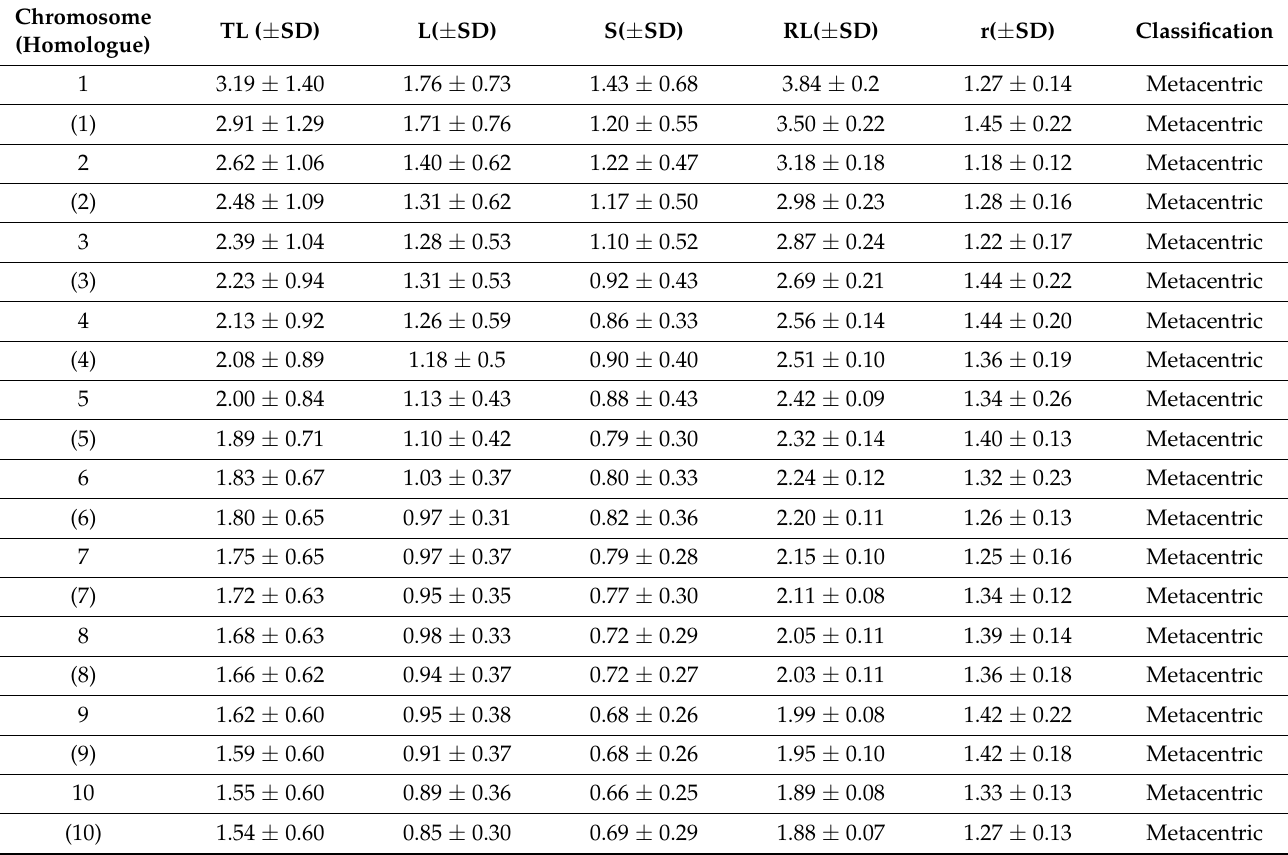
Figure 3. Mitotic chromosomes of Cyphomyrmex transversus stained with Giemsa. Species ( a ) images and ( b , c ) diploid karyotype of Cyphomyrmex transversus with 2 n = 42 chromosomes. m = metacentric, sm = submetacentric. Polymorphism in chromosome pair 15 is marked by an asterisk. Scale bar = 5 µ m. Ant image from AntWeb (www.antweb.org, accessed on 13 June 2021): Cyphomyrmex transversus (CASENT0173958, photo by: A. Nobile). Table 3. Karyomorphometric analyses of the chromosomes of Cyphomyrmex transversus . All measurements are given in “ µ m”. TL: total length; L: long arm length; S: short arm length; RL: relative length; r: arm ratio; KL: karyotype length.